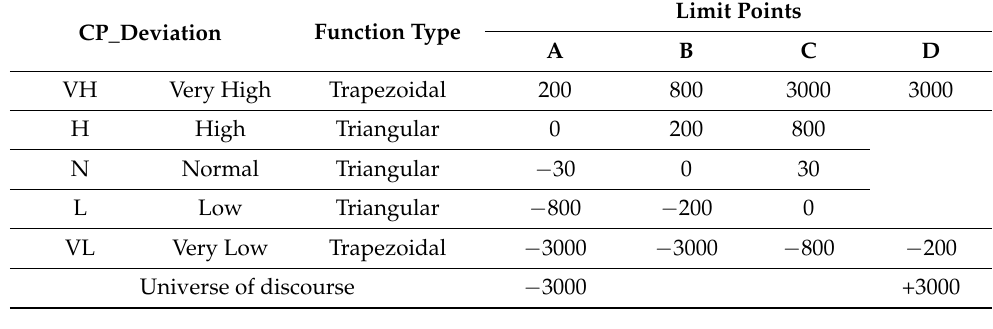
Table 2. Membership functions for variable CP_deviation ( σ _CP).